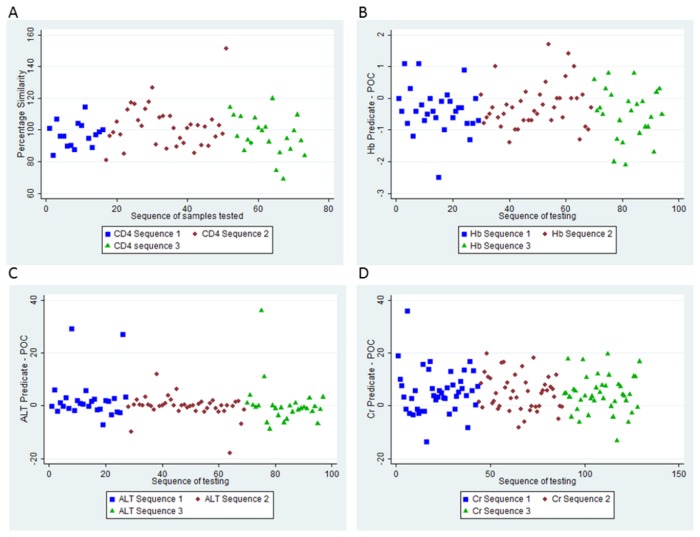
Scatter plots showing sequence of POC testing from a single fingerstick (phase II) compared to routine laboratory methodology.A) Percentage similarity for CD4. B-D) Bland Altman difference scatter plots for sequence of POC testing versus predicate methodology for Hb (B), ALT (C) and Cr (D). Blue indicates sequence 1: Reflotron followed by HemoCue and PIMA; Red indicates Sequence 2: HemoCue, Reflotron, PIMA; and green indicates Sequence 3: PIMA, Reflotron then HemoCue.